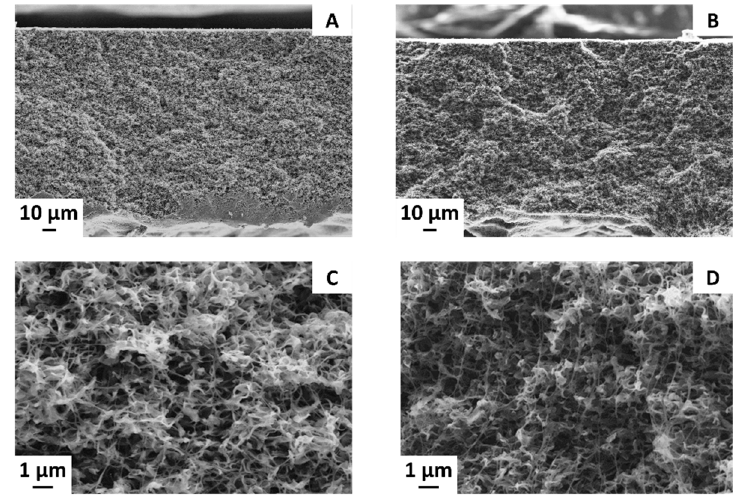
Figure 3. Cross-section images of ( A , C ) 145_0 and ( B , D ) 16_0 membranes.